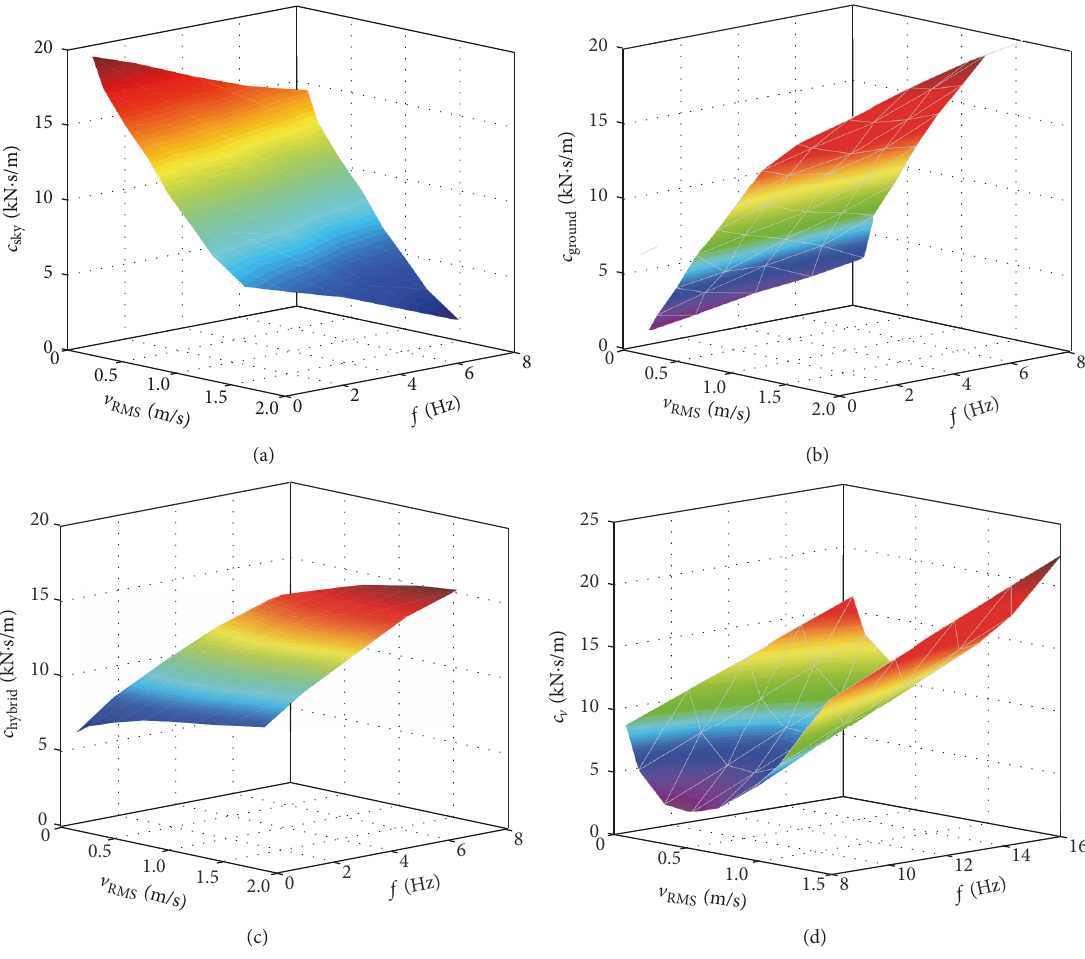
Figure 6: The optimized results of damping control gain.